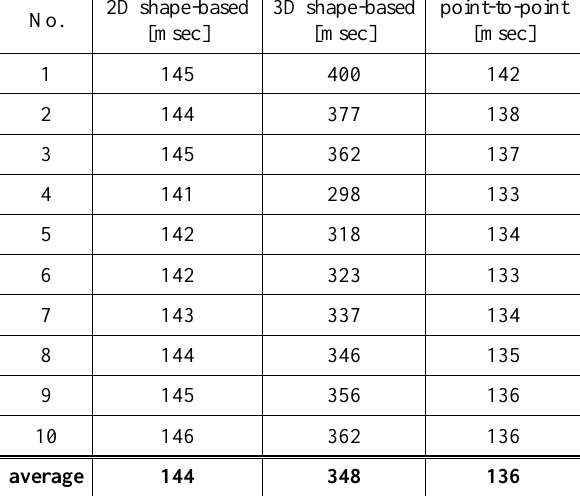
Table 2. Overview of total processing times of the introduced methods including the time for image acquisition (106